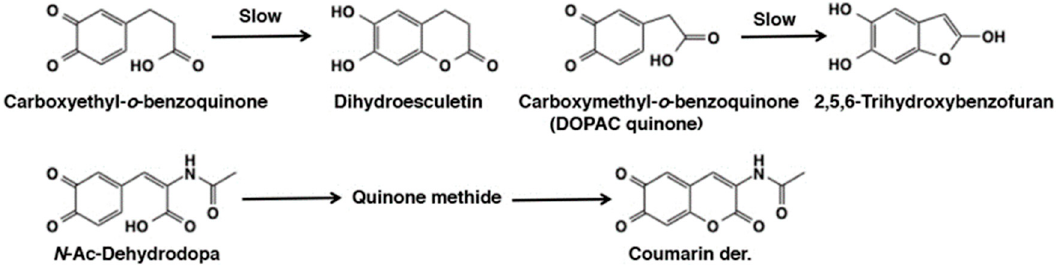
Figure 12. Reaction of o -quinones with DNA bases [58]. These adducts are isolated in the reduced